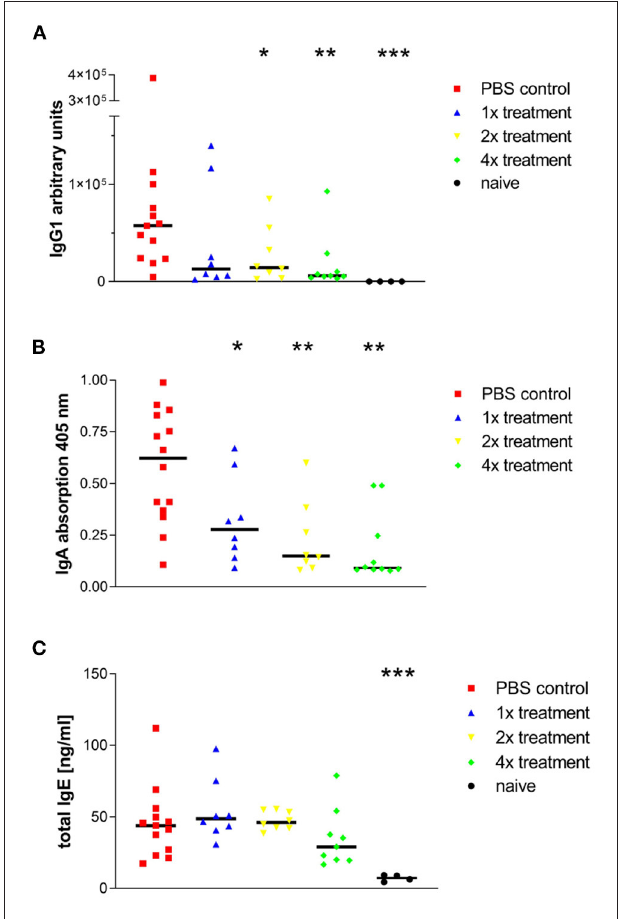
FIGURE 3 | Phl p5b-induced production of IgG1, IgA, and IgE in the lung is modulated by SCIT. Measurement of antibody concentration in the airways: (A) Allergen-specific IgG1 titers in BALFs. The standard was a pool of sera from sensitized mice, which contained high allergen-specific IgG1 titers. Lowest dilution of standard sera was set to 100AU. ( B) Allergen-specific IgA titers in BALFs. Measurement of absorption at 405nm was done in equal dilutions of BALFs (1:50). (C) Total IgE levels in BALFs. Four injections of 1mg Phl p5b lead to a reduction of IgE titers in BALFs. Naïve mice were untreated. n = 4–13 per group,* p < 0.05, ** p < 0.01 *** p < 0.001 compared to phosphate buffered saline treated control group determined by unpaired Mann-Whitney test. IgE, immunoglobulin E; IgG, immunoglobulin G; IgA, immunoglobulin A.